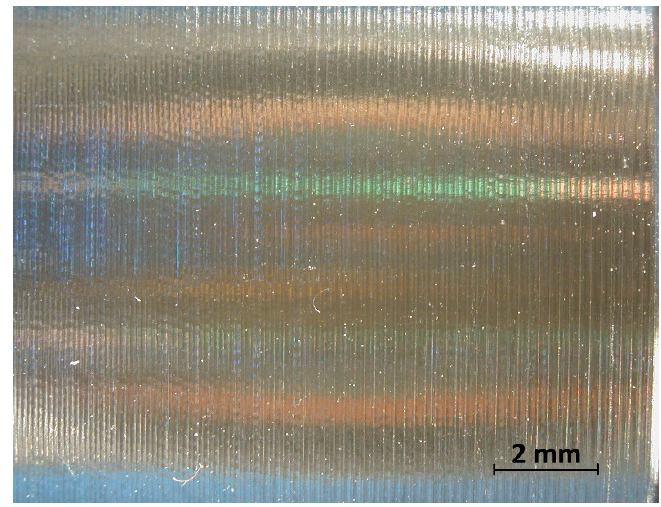
Figure 17. View of the machined surface after taper 45° turning without coolant (36 HRC).